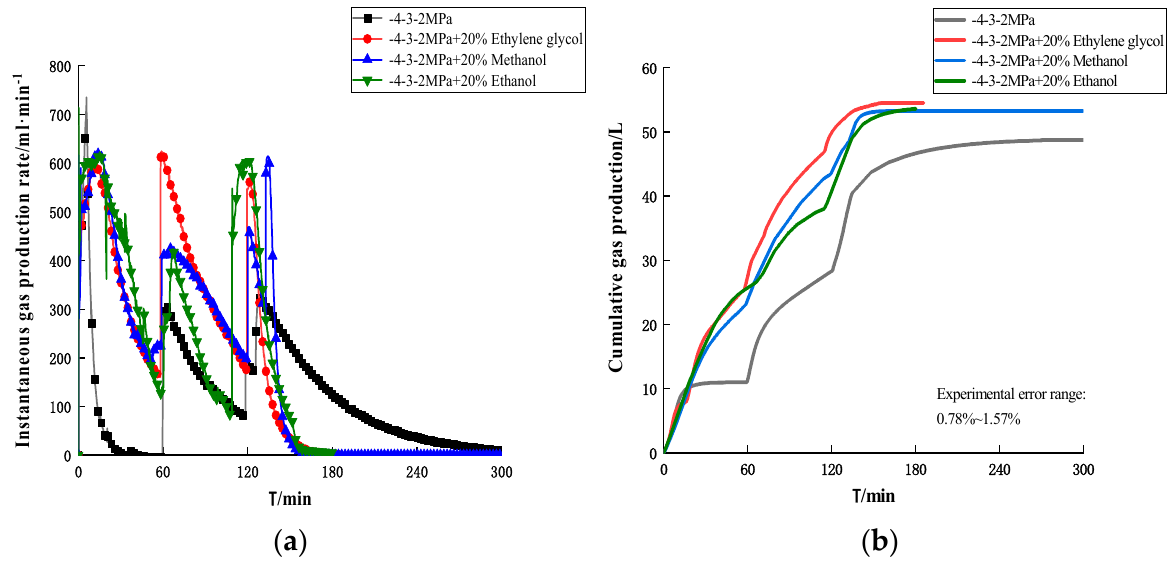
Figure 2. Decomposition curve of multi-stage depressurization and injection of 20% alcohol hydrate: ( a ) Instantaneous gas production rate; ( b ) Cumulative gas production